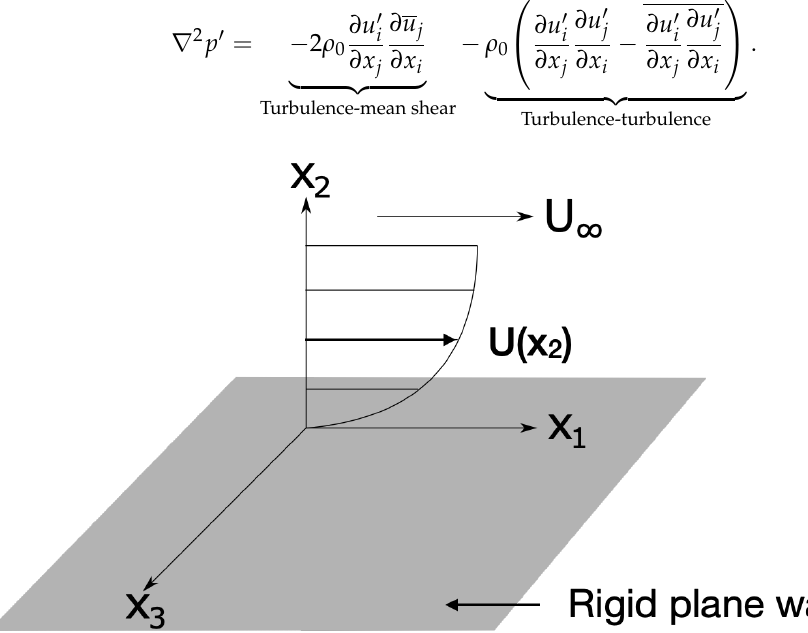
Figure 1. Reference frame for the calculation of wall-pressure statistics based on turbulence and mean flow statistics. The classical boundary layer model for which the mean flow speed is aligned with the x 1 direction, and it varies only in the normal-to-wall, x 2 direction, is also